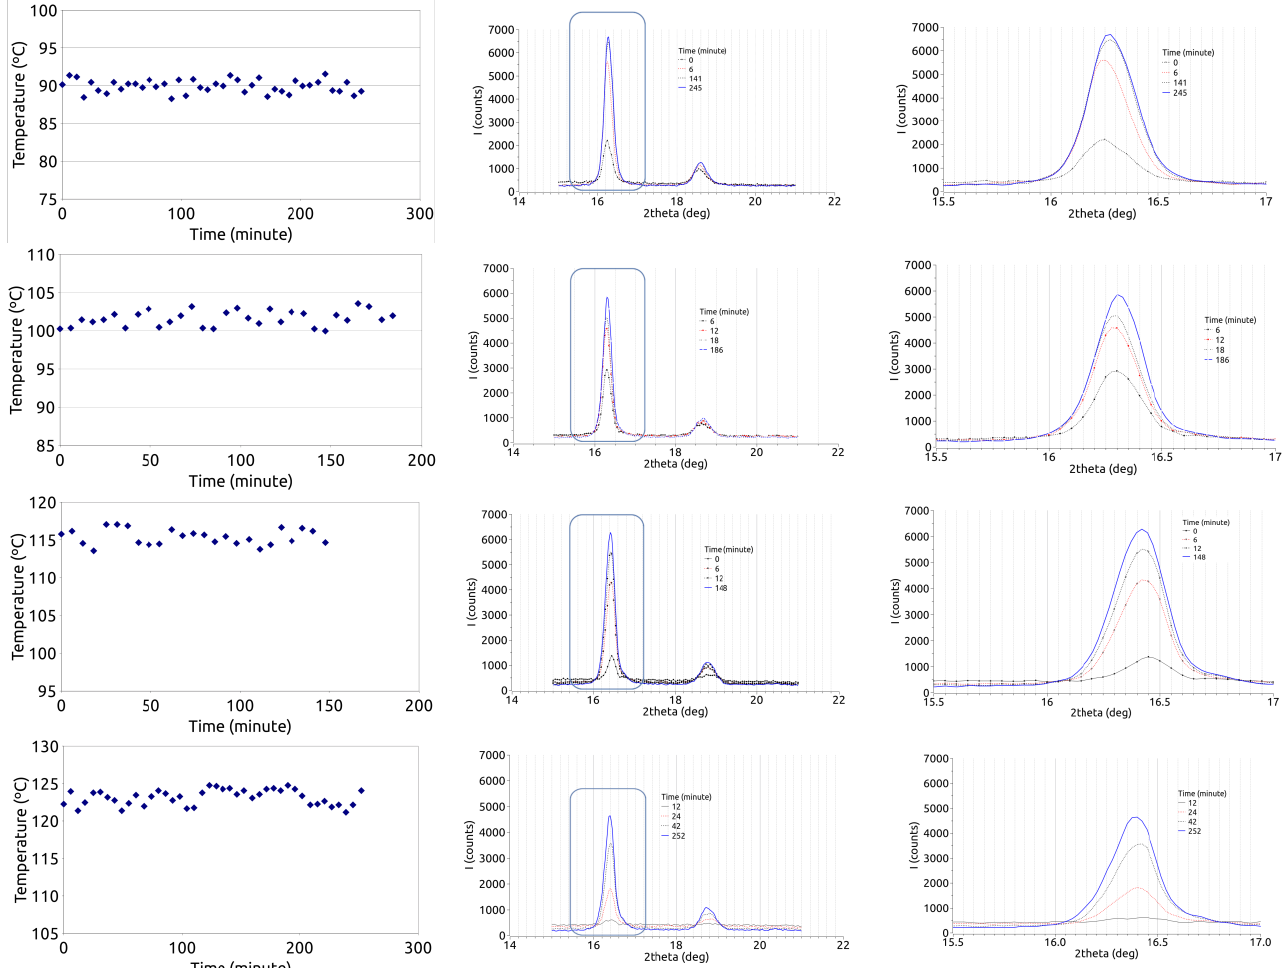
Figure 3. Temperature measured from the sample surface ( left ), sequence of diffractograms obtained at the temperatures shown in the left-hand graphs ( center ), and a zoomed area of the diffractograms ( right ).